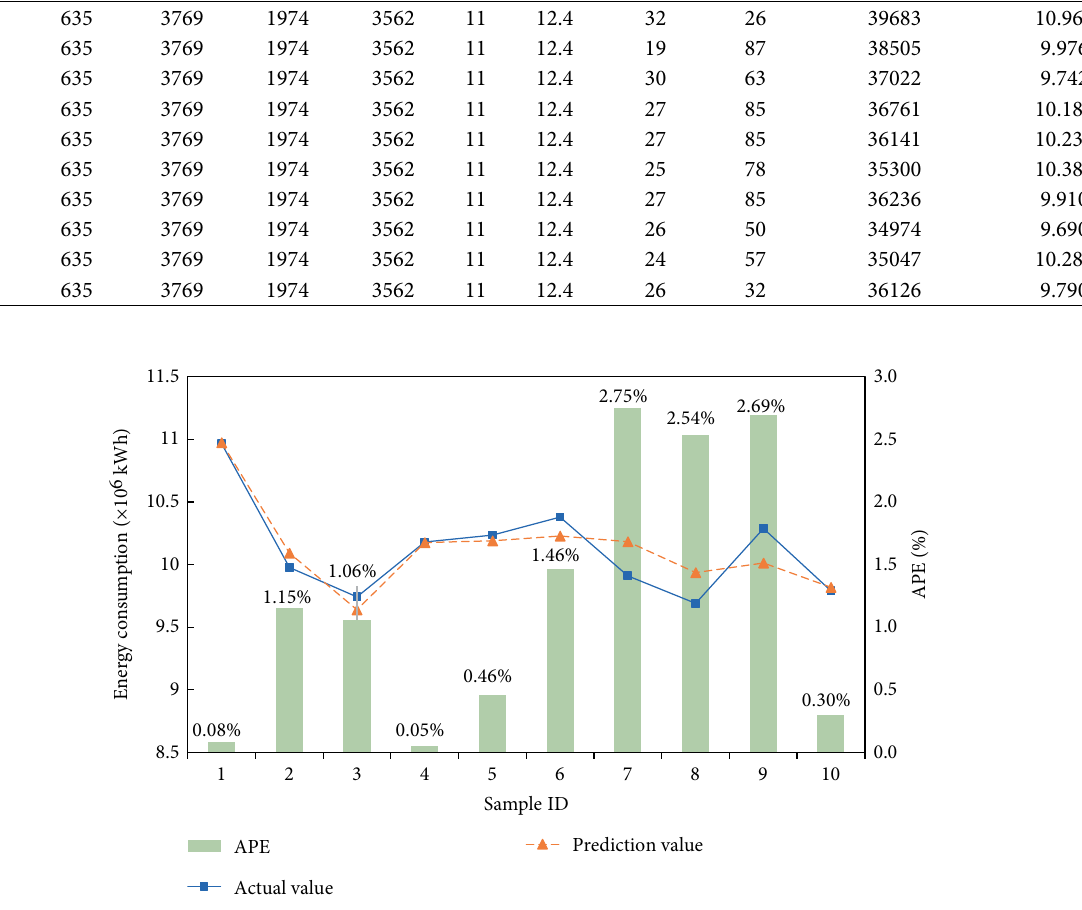
Figure 10: The prediction results of a real